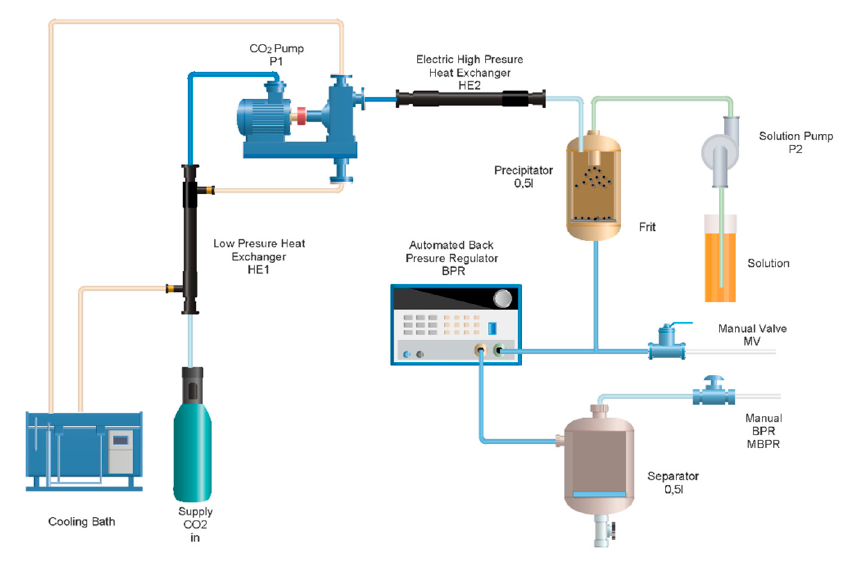
Figure 1. Schematic diagram of the supercritical antisolvent device, SAS1.